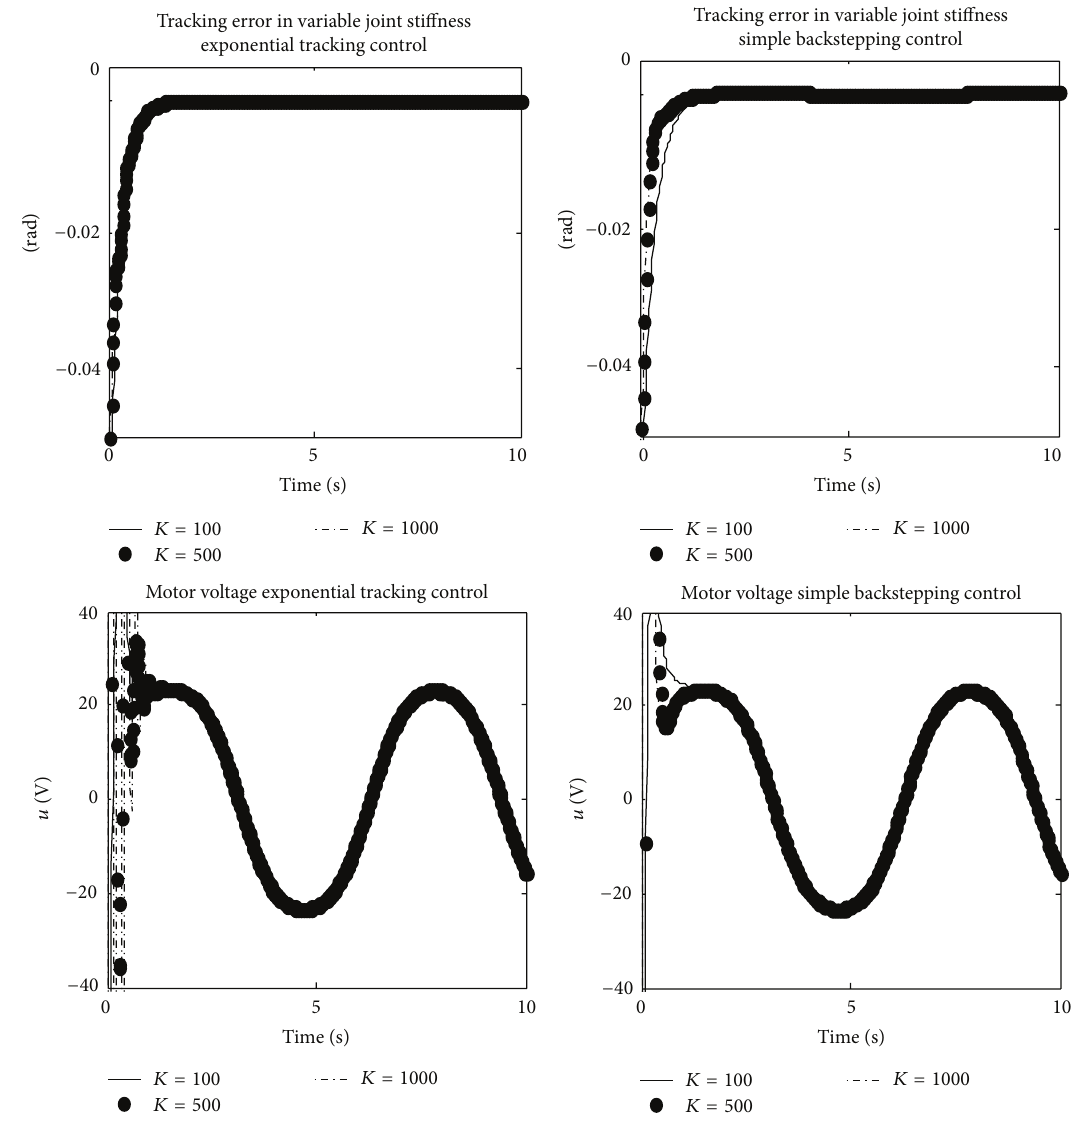
Figure 4: Comparative tracking performance in variable joint